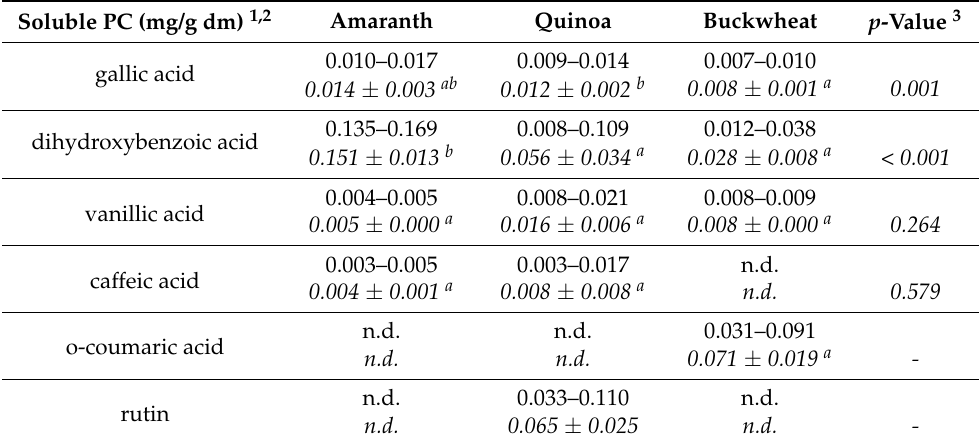
Table 7. Contents of soluble phenolic compounds (mg/g dm) in amaranth ( n = 8), quinoa ( n = 7) and buckwheat ( n = 10) wholemeal